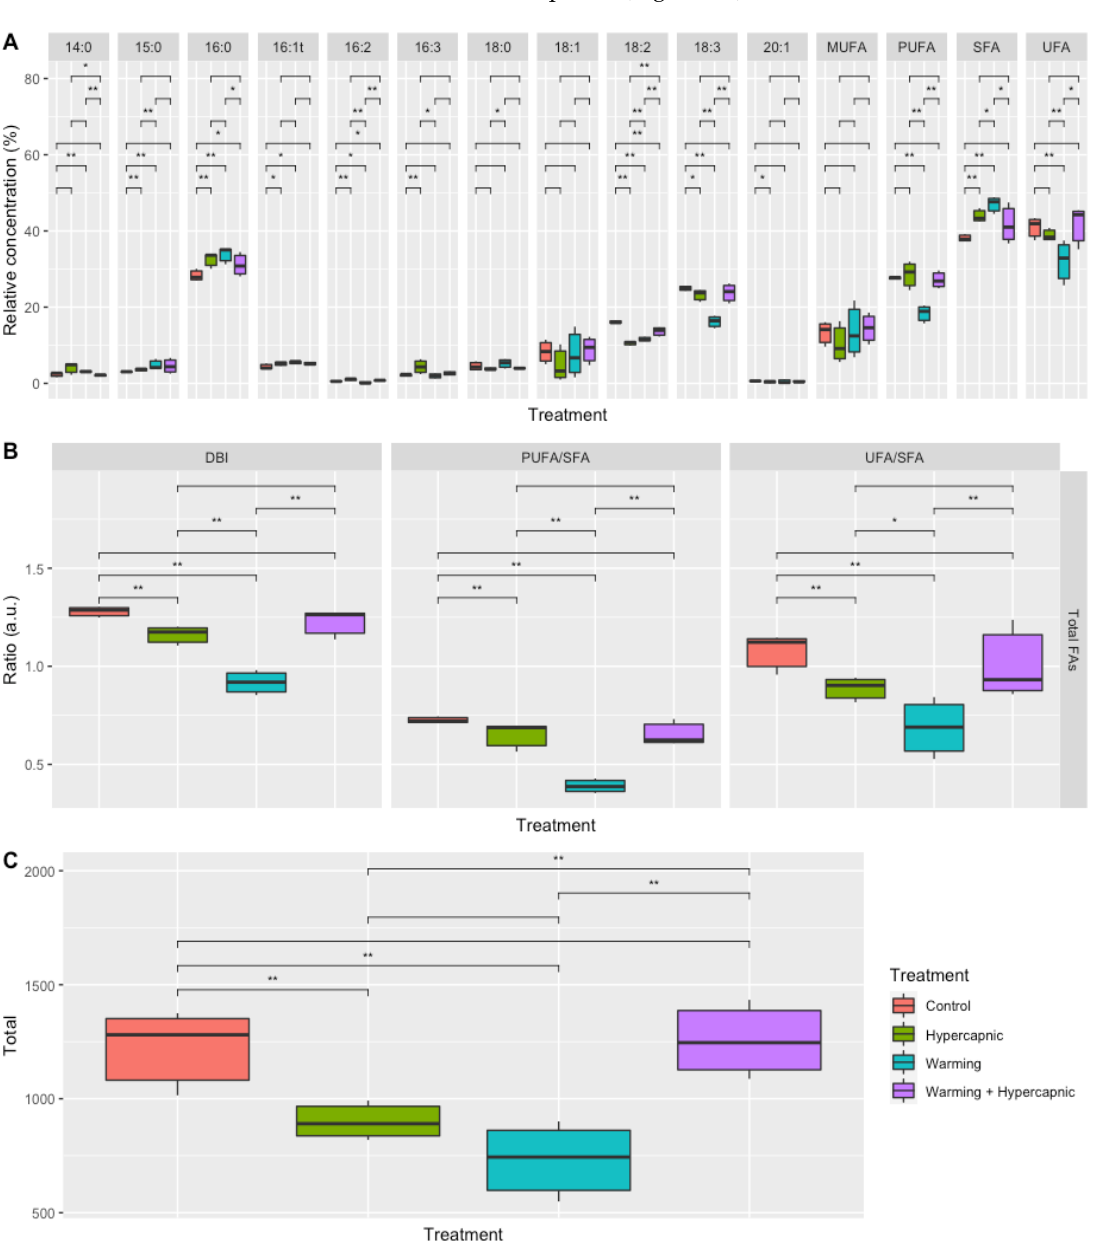
Figure 1. Zostera noltii leaf total fatty acid concentration ( A ), fatty acid indexes and ratios ( B ) (double-bond index, DBI; polyunsaturated to saturated fatty acid ratio, PUFA/SFA; unsaturated to saturated fatty acid ratio, UFA/SFA)), and total leaf fatty acid contents ( C ) under exposure to control, hypercapnic, warming and combined stress conditions ( n = 3 per treatment; asterisks denote statistical differences among treatments at p < 0.05 (*) and p < 0.01 (**)). The leaf total fatty acid canonical analysis of principal (CAP) is shown in Figure 2. The cross-validation step presented a 100% classification efficiency of the samples belonging to the control and warming group, indicating a high specificity of the fatty acids as biomarkers of exposure to warming. This classification had a lower efficiency in